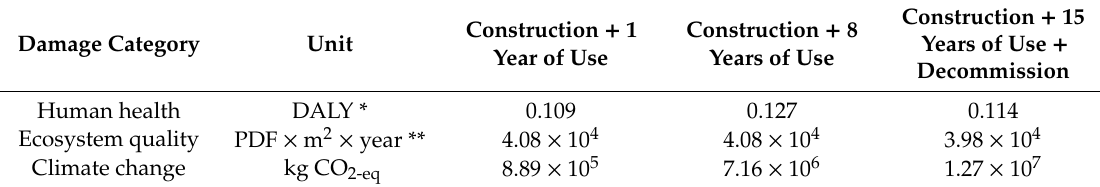
Table 4. Impact assessment and characterization for the 500-kW heat output natural gas-fired boiler